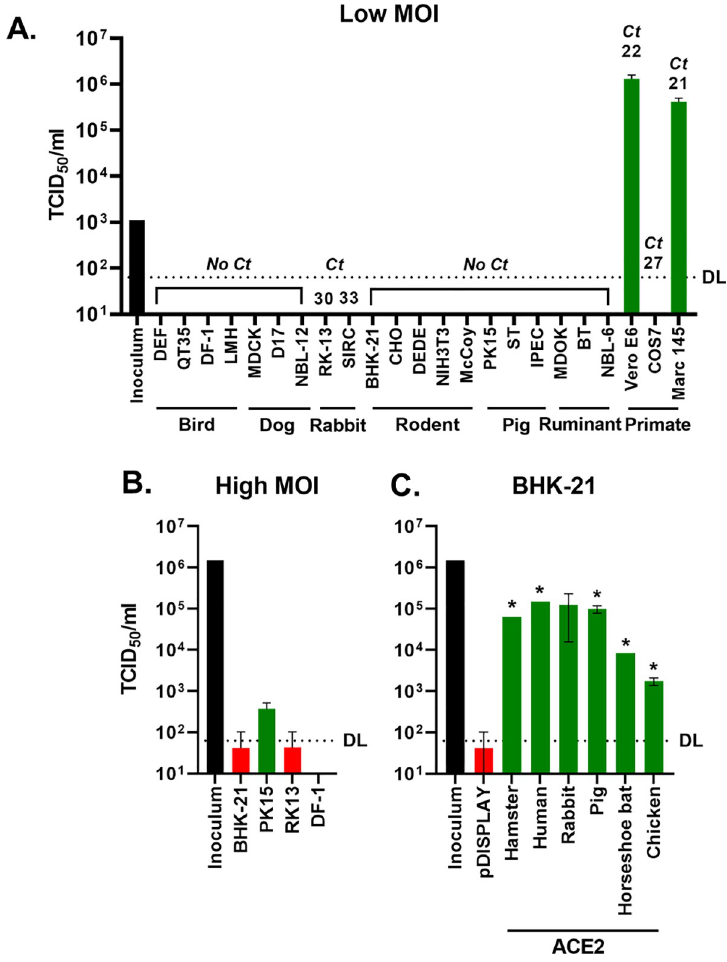
Fig 3. A cognate ACE2 receptor is required for SARS-CoV-2 infection. (A) Various cell lines derived from birds, dogs, rabbits, rodents, pigs, ruminants, and primates were experimentally infected with SARS-CoV-2 at a MOI of 0.001. At 72 h postinfection, the supernatants from cells were harvested and titred by TCID-50. For each cell line, RNA from uninfected cells was also extracted, and RT-qPCR was performed to detect ACE2 mRNA, with the value above each line indicating the cycle when PCR positivity was achieved (Ct). (B) Four of the same cell lines were infected again, this time at high MOI (1). (C) BHK-21 hamster cells were transiently transfected with ACE2 expression constructs (or a vector control [pDISPLAY]) before being infected with SARS-CoV-2 at high MOI (1). � p < 0.05 Student t test, compared with pDISPLAY. For all high MOI experiments, supernatant samples were harvested at 48 hpi for titration by TCID-50. The DL for the TCID-50 is indicated. In all experiments, the initial inoculum used for infection was titred, and infections were performed in duplicate, with error bars denoting standard deviation from the mean. The data underlying this figure may be found in S1 Data. ACE2, angiotensin-converting enzyme 2; BHK-21, baby hamster kidney 21; Ct, cycle threshold; DL, detection limit; MOI, multiplicity of infection; RT-qPCR, reverse transcription quantitative PCR; SARS-CoV-2, SARS Coronavirus 2; TCID50, 50% tissue culture infective